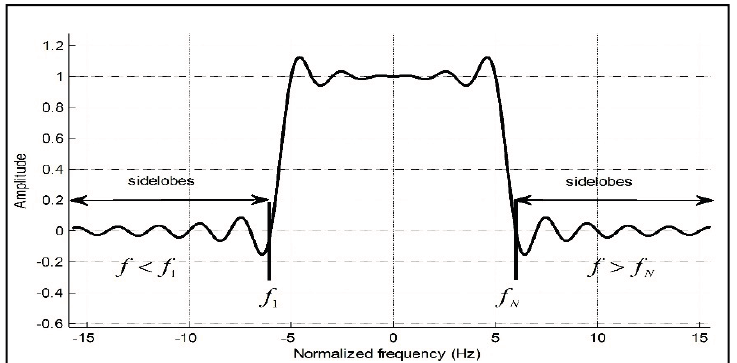
Figure 2. Transmitted NCOFDM signal in frequency domain.